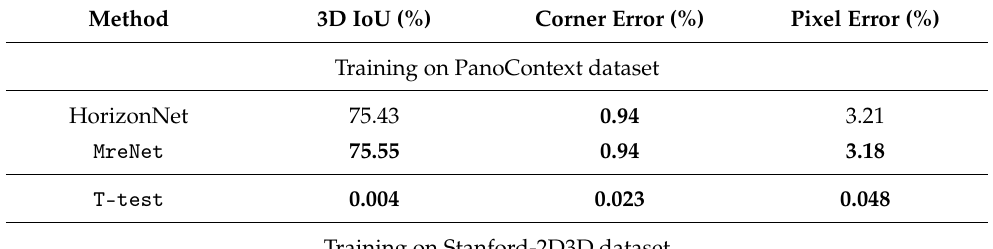
Table 2. Quantitative results of cuboid layout estimation evaluated on the Stanford-2D3D [25] dataset. Our approach outperforms all listed methods under all settings.